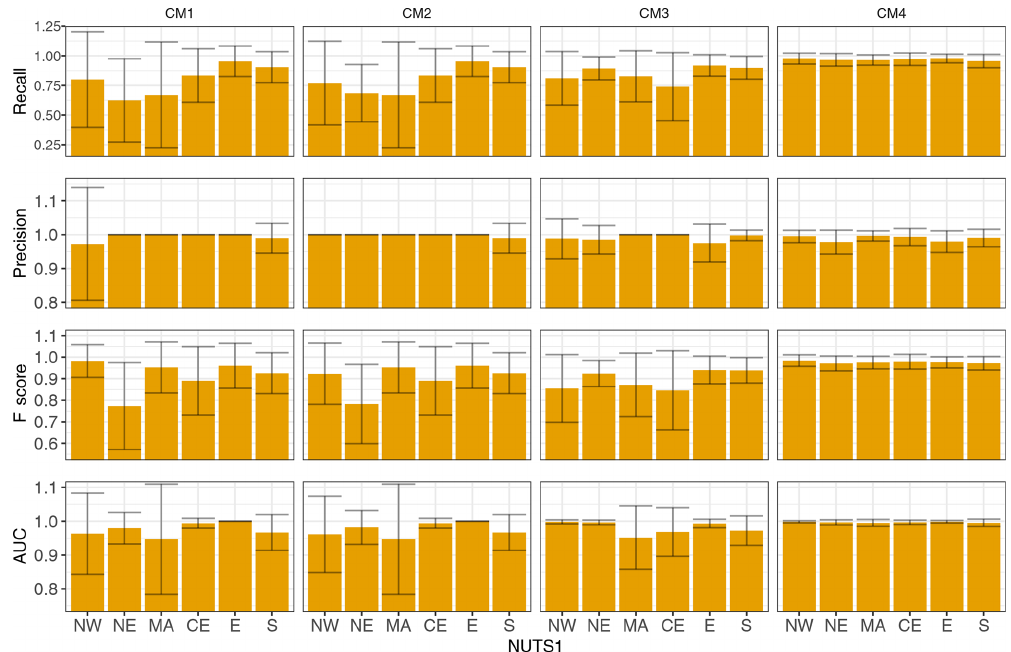
Figure 7. Performance metrics (recall, precision, F score, and AUC) of the classification random forest model when performing a repeated 10-fold cross-validation using all the data. All counting methods are shown. The error bars show the standard deviation of these metrics.